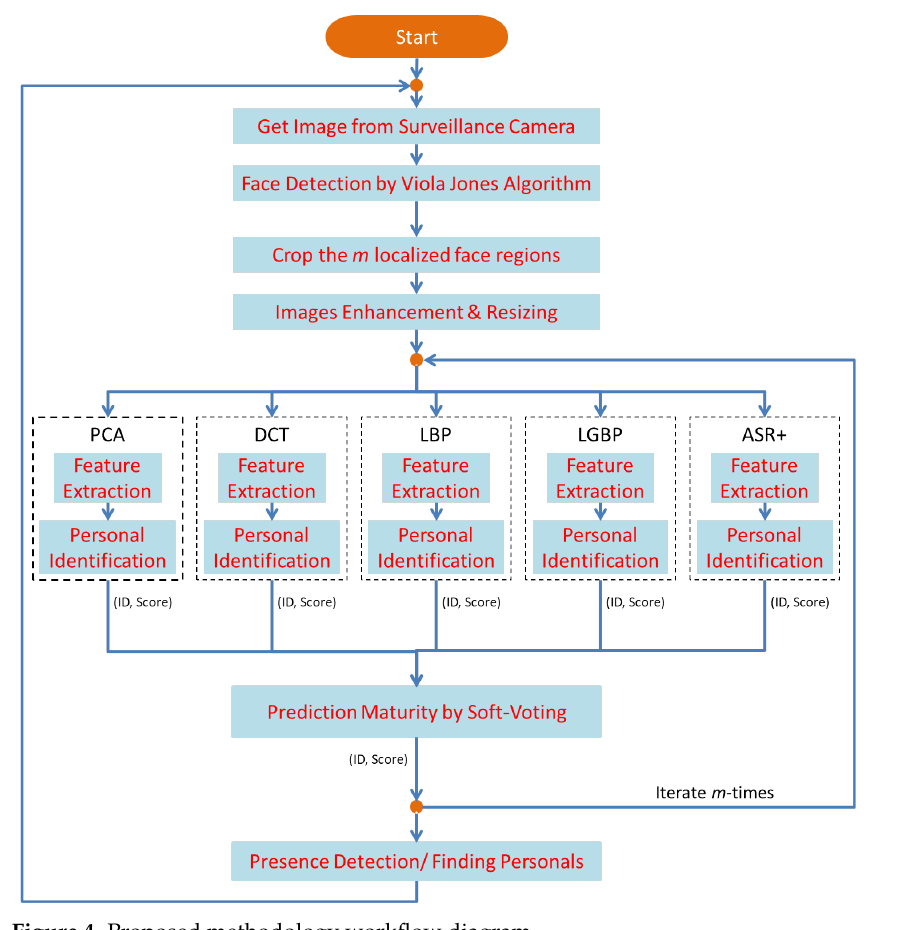
Figure 4. Proposed methodology workflow diagram.